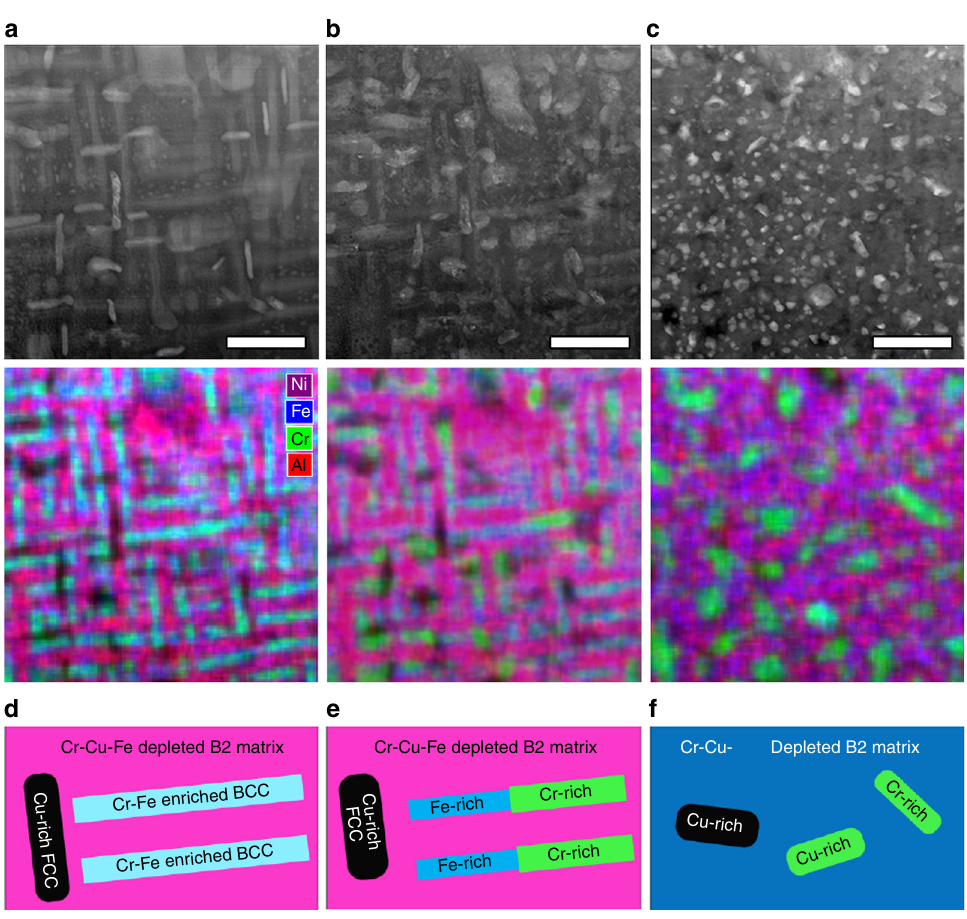
Fig. 6 In situ STEM/EDS demonstrate rapid changes in the microstructure between 600 and 700 °C. Representative ADF STEM images and corresponding EDS Maps (Ni, Fe, Cr, and Al) of the Al 1.3 CoCrCuFeNi microstructure. a Initial room-temperature microstructure shows an Al-Ni-enriched matrix with Cr- Fe-enriched plates. b Heat treatment at 600 °C causes separation of Cr and Fe within the plates. c Heat treatment at 700 °C breaks down the coherent microstructure. The observed microstructures are represented schematically in d room temperature, e 600°C, and f 700 °C. Scale bars are 500